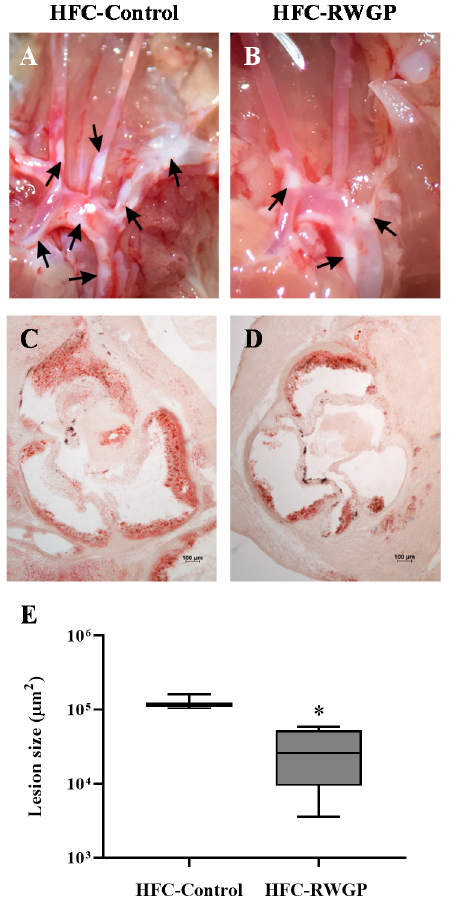
Figure 5. Effect of RWGP supplementation in atherosclerotic lesions of SR-B1 KO/ApoER61 h/h mice fed with atherogenic diet. Representative images obtained during dissections of aortic arches from mice fed HFC-Control ( A ) or HFC-RWGP ( B ) diets for 14 days. Representative cross sections of aortic roots stained with Oil Red O from HFC-Control- ( C ) or HFC-RWGP- ( D ) fed mice at day 14. ( E ) Quantitative analysis of aortic valve atherosclerotic lesion areas. Data are shown in box plots (box, 25th to 75th percentiles; whiskers, median and IQR) ( n = 5–7). * p < 0.05 vs. HFC-Control based on two-way ANOVA.